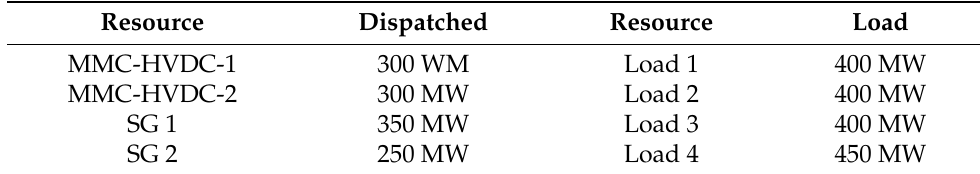
Table 2. Base scenario of the simulation studies.